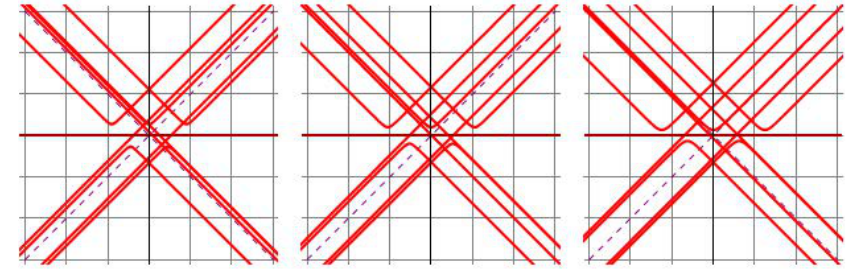
Fig. 9. Timelike elastic curves β ψ ( ψ = − π / 4,0, π / 6